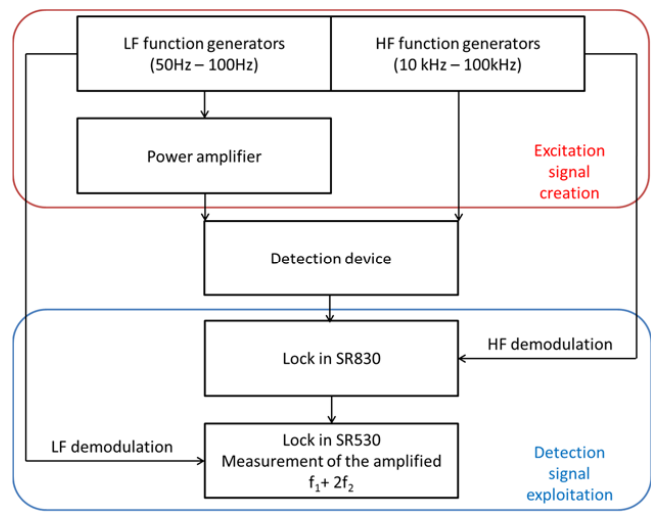
Figure 5. Outline chart of the measurement test bench.